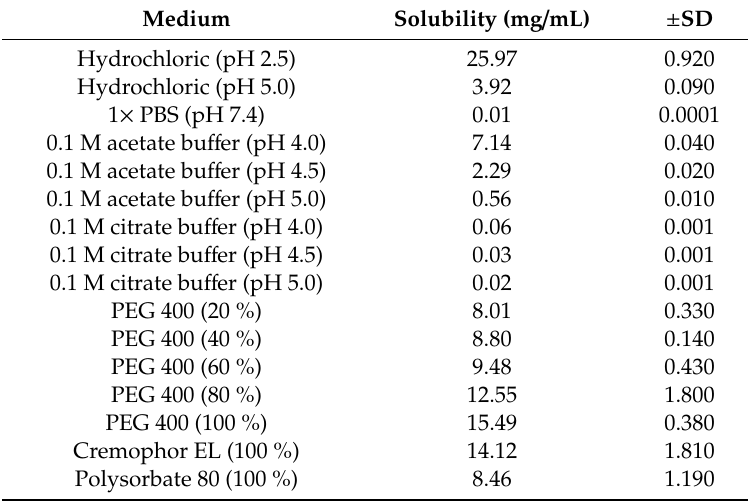
Table 2. Equilibrium solubility measured at di ff erent pHs and excipients by HPLC.